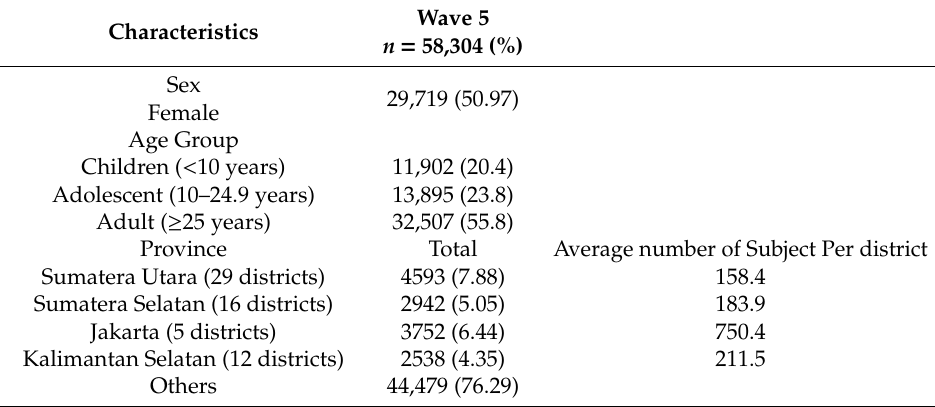
Table 1. Subject characteristics of Indonesian Family Life Survey (IFLS) data Wave 5 ( n (%)) and number of subjects per province and